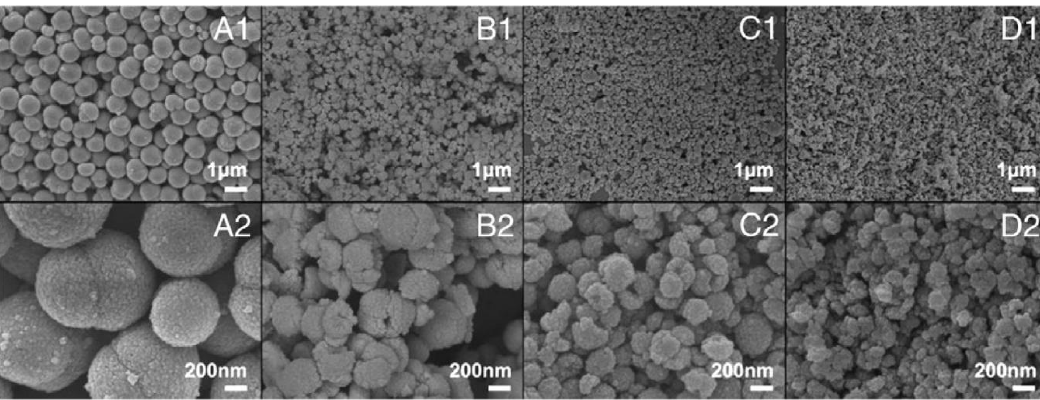
Figure 55. SEM images of ZnO: ( A ) pure, ( B ) 0.5% Ag, ( C ) 1.0% Ag and ( D ) 3.0% Ag. Reprinted from